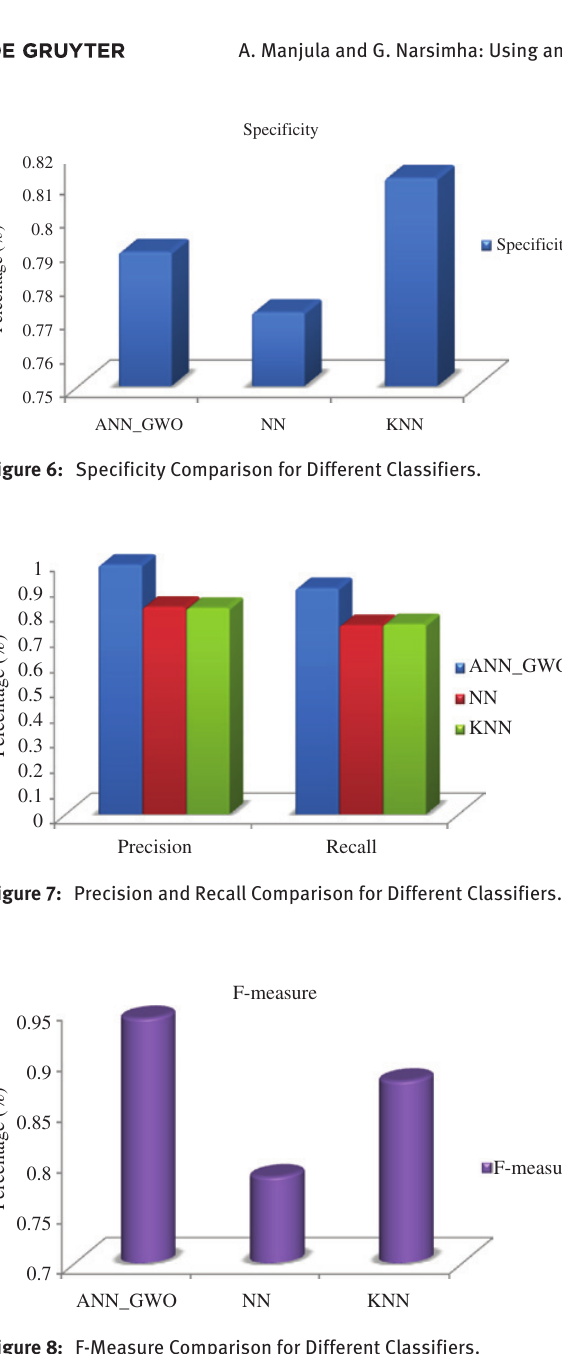
Figure 8: F-Measure Comparison for Different